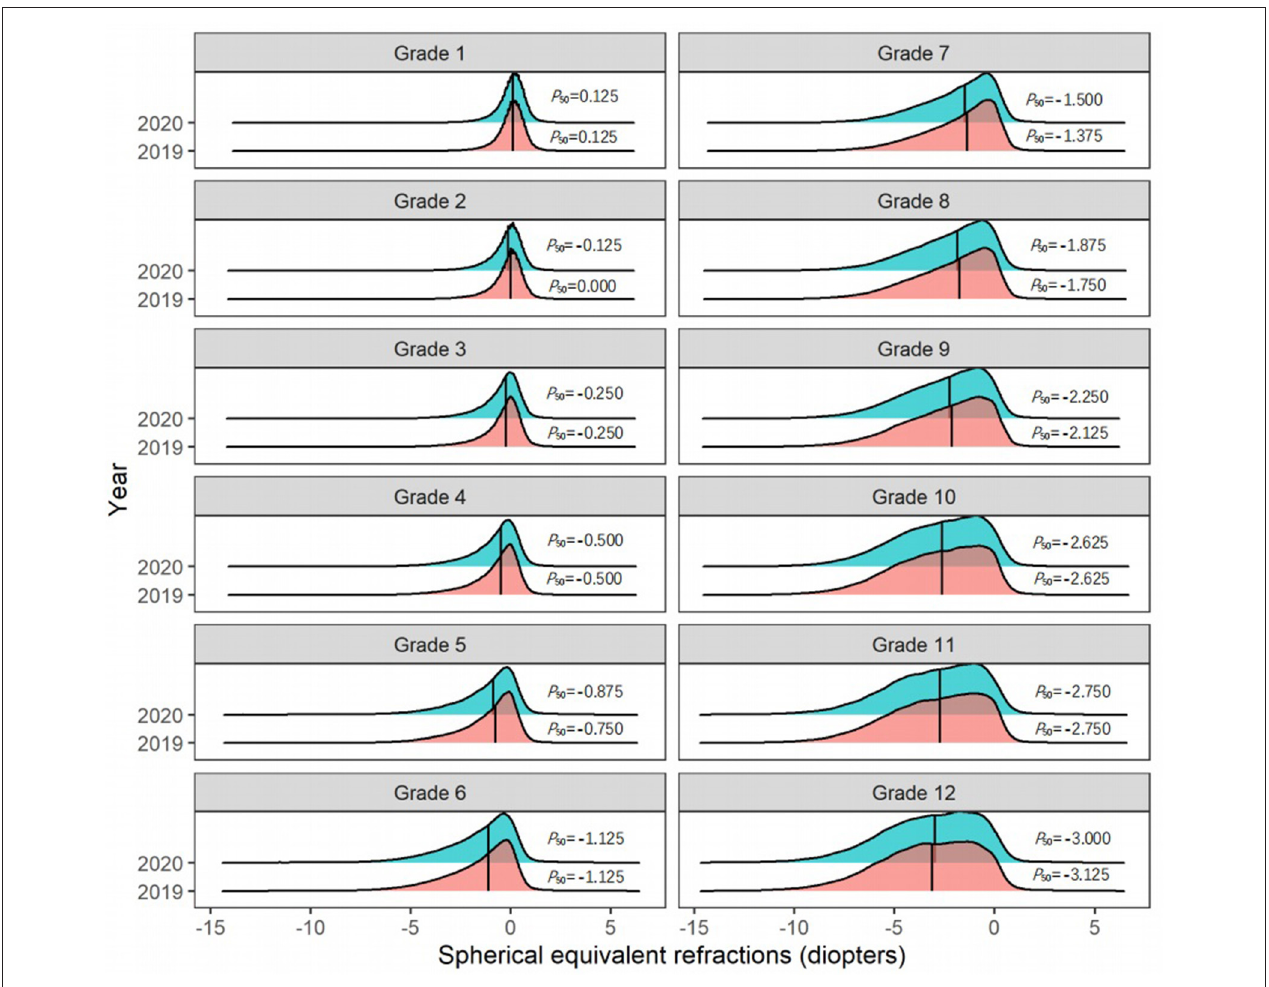
FIGURE 3 | The distribution curves of spherical equivalent refraction among elementary and middle school students in 2019 and